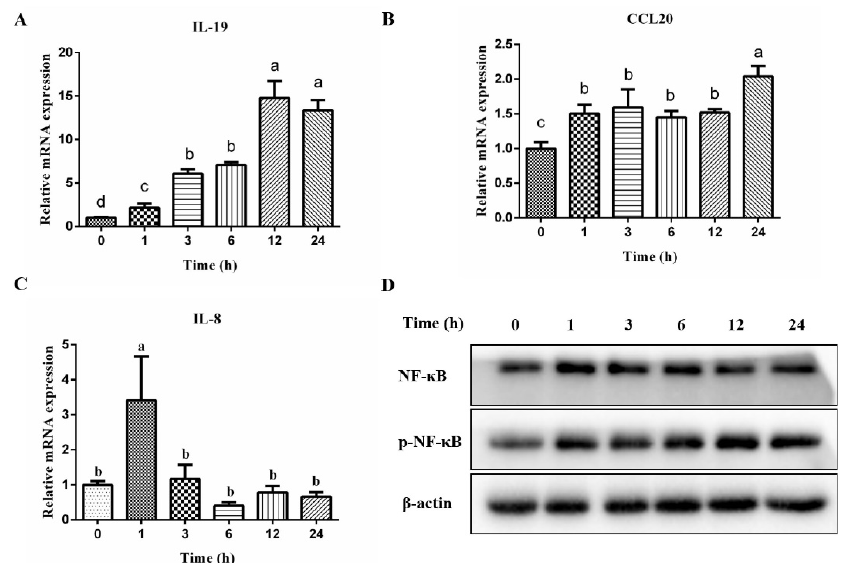
Figure 1. Effects of PEDV infection on inflammatory cytokine expression in IPEC-J2 cells. IPEC-J2 cells were infected with PEDV (1 MOI) for 1 h, and then the cells were washed with PBS and cultured with fresh culture medium for different times. After this, the cells were collected for RT-qPCR ( A – C ), n = 4 and Western blotting analysis ( D ). a,b,c,d Means not sharing the same superscript differ at p < 0.05.